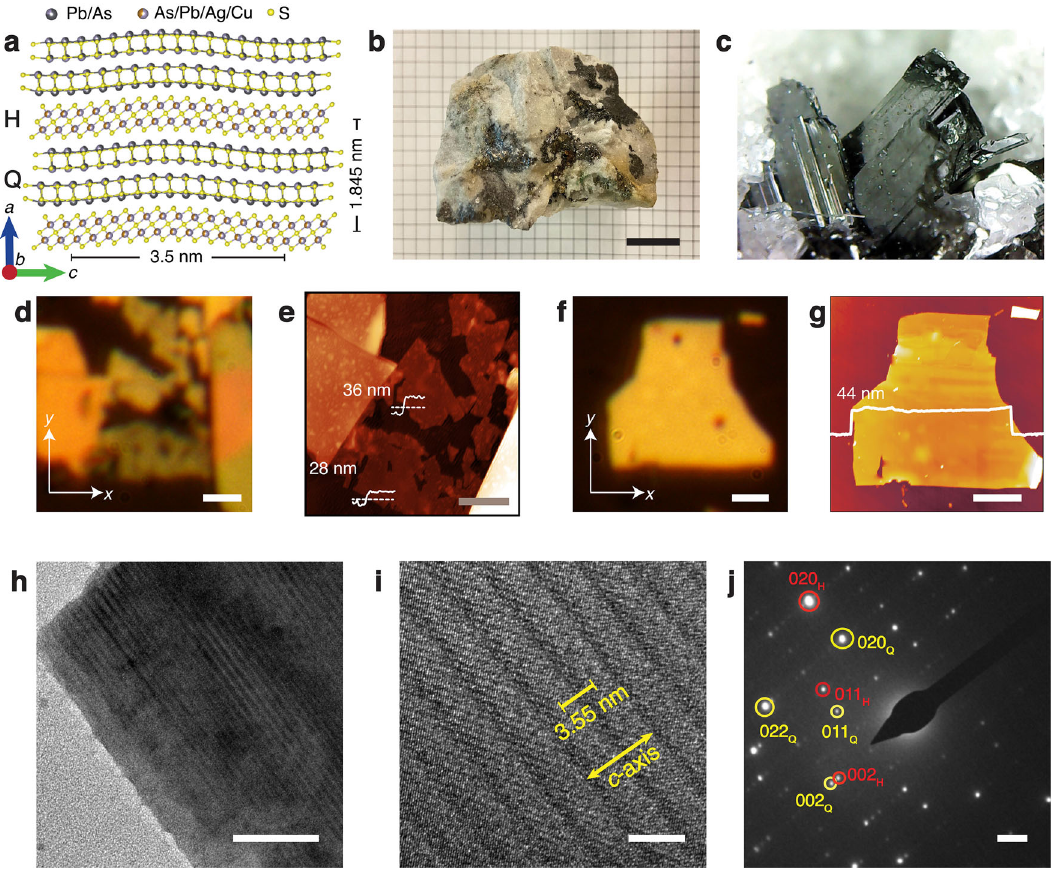
Fig. 1 Morphology, crystal structure, and mechanical exfoliation of lengenbachite. a Schematic diagram of lengenbachite crystal structure composed of alternating PbS-like pseudo-tetragonal layer (Q-layer) and M 2 S 3 -like pseudo-hexagonal layer (H-layer). b Optical image of the mineral rock where clusters of bulk lengenbachite crystals are formed on dolomite. Scale bar is 20 mm. c Zoomed-in view of one such cluster, where several tabular and blade-like crystal plates (about 3 – 5 mm long) with steel-gray color are contained in a vug in white dolomite. Field of view is 10 mm wide. d Re fl ection microscope image of mechanically exfoliated lengenbachite crystals on quartz. e AFM image of the same fl akes where the line pro fi les in the inset show that the two crystals are 28 and 36 nm thick. f Re fl ection image of an isolated lengenbachite fl ake. g AFM image showing that the fl ake thickness is 44 nm. Scale bars are 2 µm. h TEM image of a lengenbachite fl ake displaying the characteristic striped patterns along the c -axis, caused by the out-of-plane rippling due to the forced commensuration of Q-layers and H-layers. Scale bar is 40 nm. i HRTEM image illustrating the atomic arrangements. Scale bar is 5 nm. j Corresponding SAED pattern consisting with diffraction spots associated with Q-layer (yellow) and H-layer (red). Scale bar is 1 nm − 1